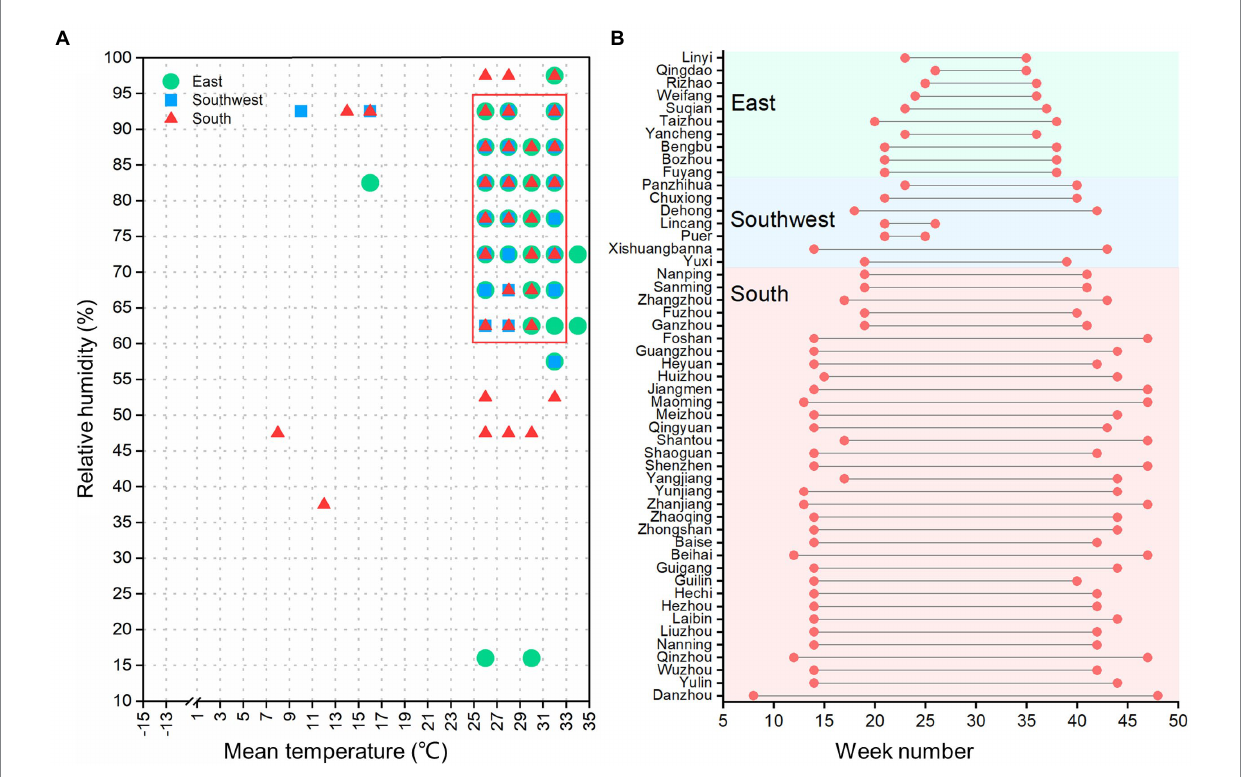
FIGURE 5 (A) Climate risk windows of scrub typhus incidence in each prefecture-level administrative region. The red frame area denotes the common climate risk window for scrub typhus for all study regions. (B) Duration of the common climate risk window weeks in each prefecture-level administrative region, with the first green point denoting the starting week and the second green point denoting the ending week,